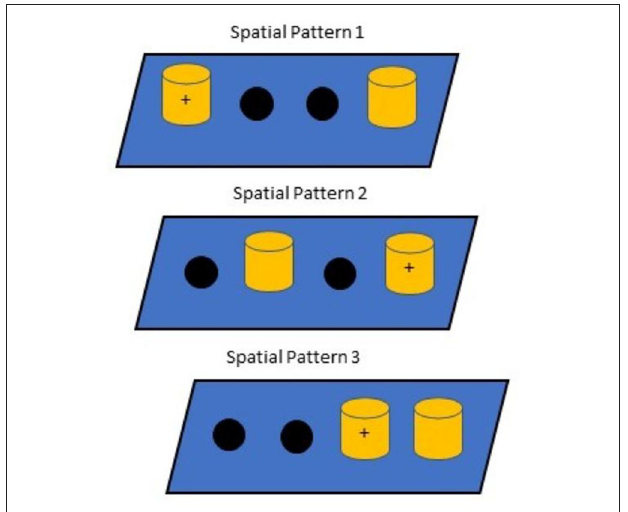
FIGURE 1 | Spatial Discrimination Patterns. Correct responses are indicated as ( + ), which intentionally ensured that no position was correct for more than one problem. Pattern presentation occurred in the same order each